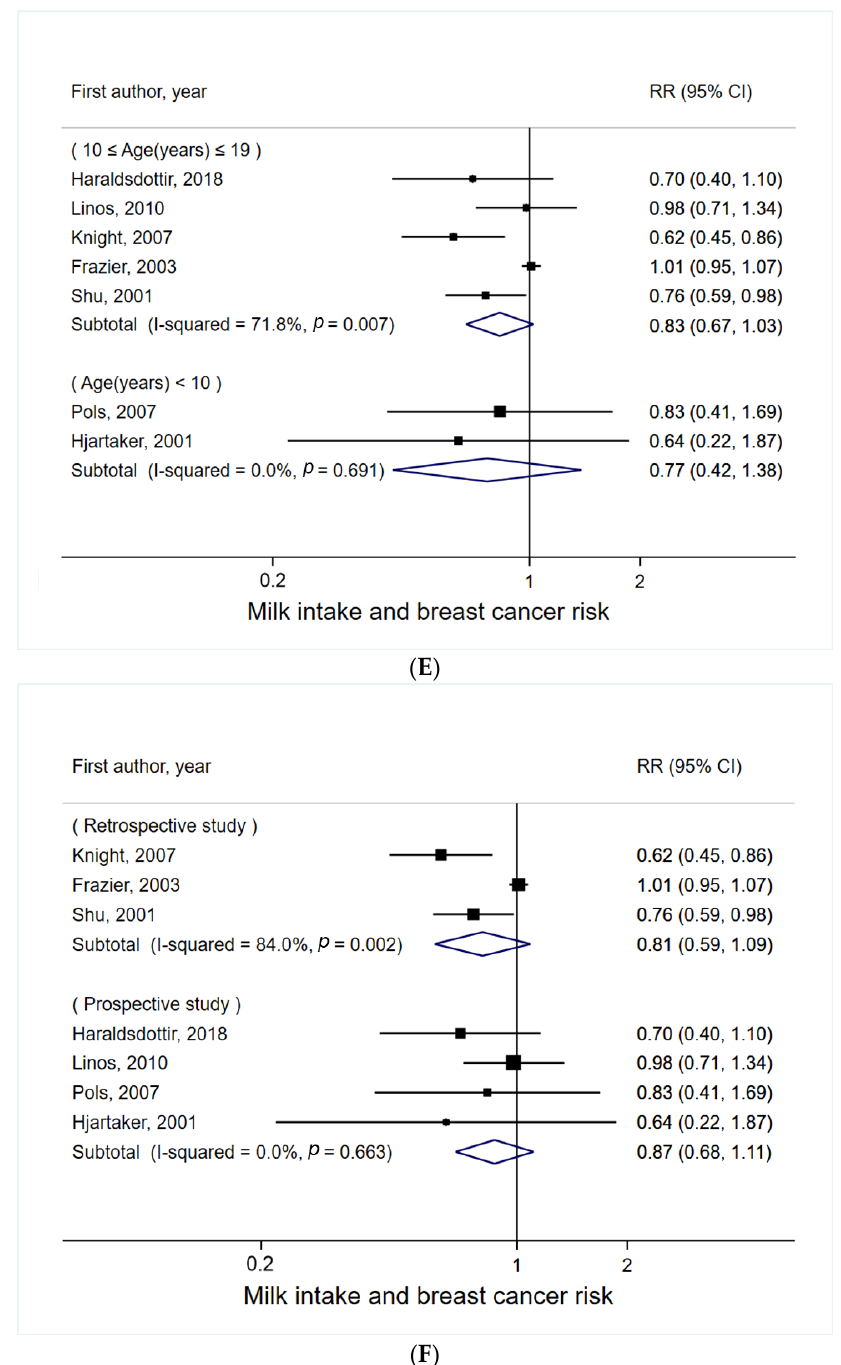
Figure 2. Meta-analysis of milk intake in early life ( A ) with any breast cancer risk, ( B ) by menopausal status, ( C ) by cancer stage, ( D ) by fat content of milk, ( E ) by life stage of milk intake, and ( F ) by study design. For each study, the RR and corresponding 95% CI of individual studies are marked by the location of the black box and the width of the horizontal line, respectively. The size of the box indicates the weight that the RR receives when calculating the summary estimate. The summary RR and its 95% CI are represented by the center and weight of the diamond, respectively.